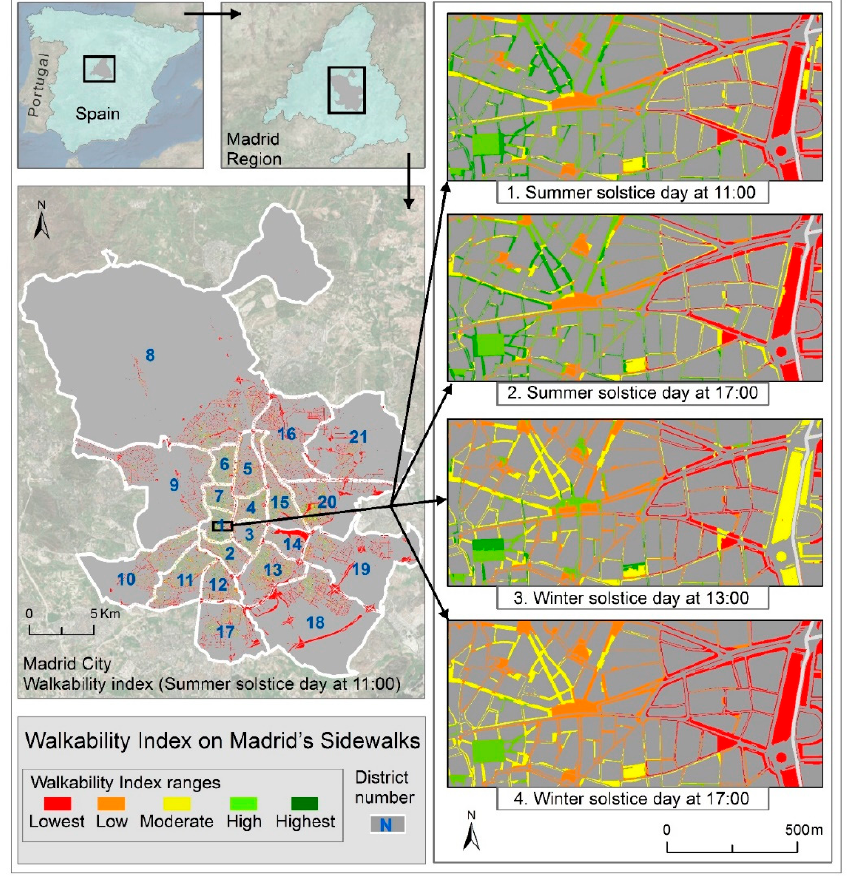
Figure 2. Walkability indices (WI) on a sector of Madrid City at four different times.